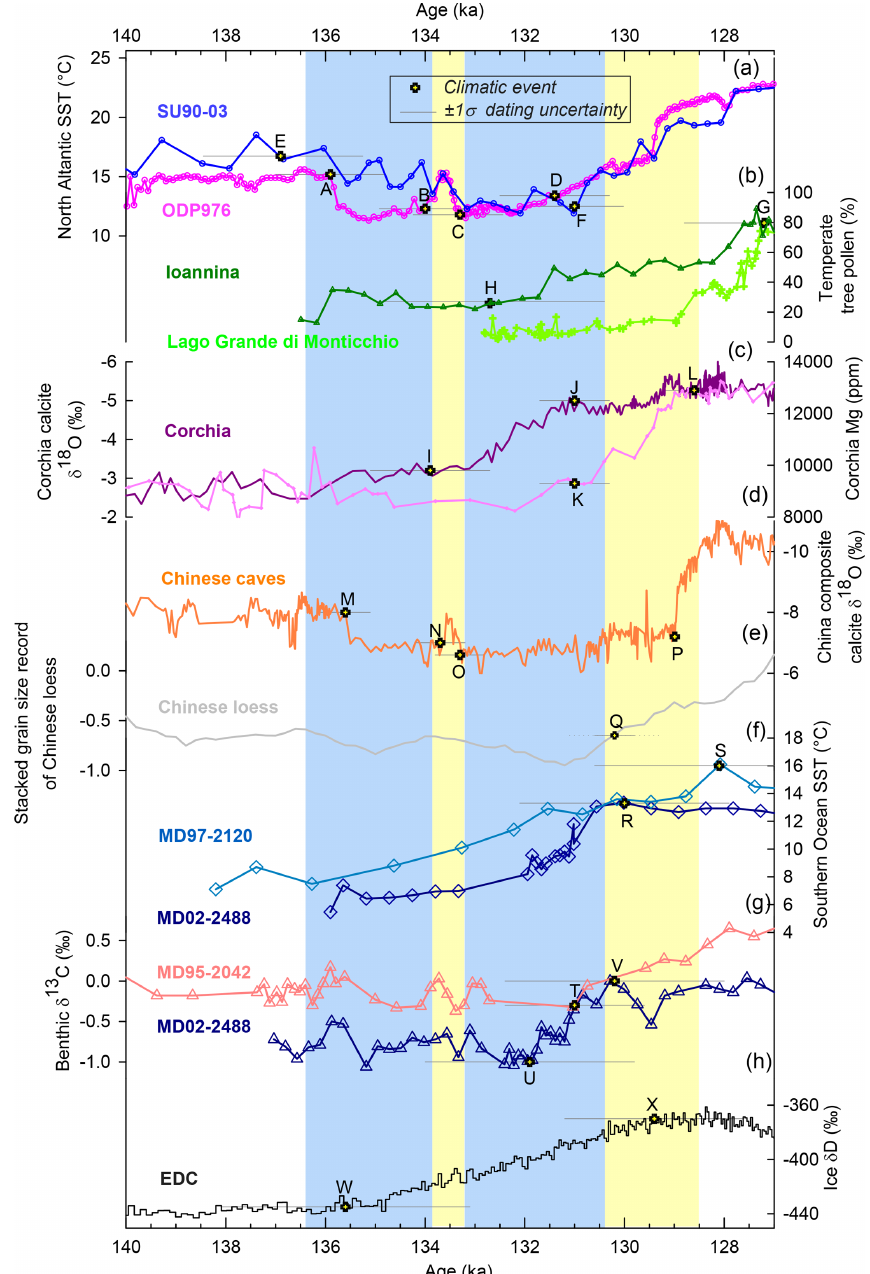
Figure 9. Selection of paleo-records illustrating climatic and environmental changes between 140 and 127ka. (a) SST records from North Atlantic cores ODP-976 (pink) (Martrat et al., 2014) and SU90-03 (blue) (Chapman et al., 2000). (b) Percentage of temperature tree pollen from the Greek Ioannina sequence (dark green) (Tzedakis et al., 2003) and from the Italian Lago Grande di Monticchio (LGdM) sequence (light green) (Brauer et al., 2007). (c) Composite speleothem calcite δ 18 O record from the Italian Corchia Cave speleothem (purple) and Corchia Cave deposit Mg concentration Mg concentration (Drysdale et al., 2007, 2019) (d) Composite calcite δ 18 O record from the Chinese Hulu, Sanbao and Dongge caves speleothems (orange) (Cheng et al., 2016). (e) Stacked grain size record of Chinese loess (light grey) (Yang and Ding, 2014). (f) SST records from Southern Ocean cores MD97-2120 (light blue) (Pahnke et al., 2003) and MD02-2488 (dark blue) (Govin et al., 2012). (g) δ 13 C record from North Atlantic core MD95-2042 (light pink) (Shackleton et al., 2003) and Southern Ocean core MD02-2488 (dark blue) (Govin et al., 2012). (h) Antarctic ice δ D record from EPICA Dome C (Jouzel et al., 2007) on the AICC2012 chronology (black) (Bazin et al., 2013; Veres et al., 2013). Letters and yellow and black crosses indicate the major changes identified in the paleo-climatic records and their ± 1 σ dating uncertainty (horizontal grey bars, Tables 4 and 5). Chronologies and associated references are detailed in Tables 4 and 5. No details on the dating errors attached to the Chinese loess stacked grain size record are provided in Yang and Ding (2014); the 1 σ error should thus be treated as an underestimated dating